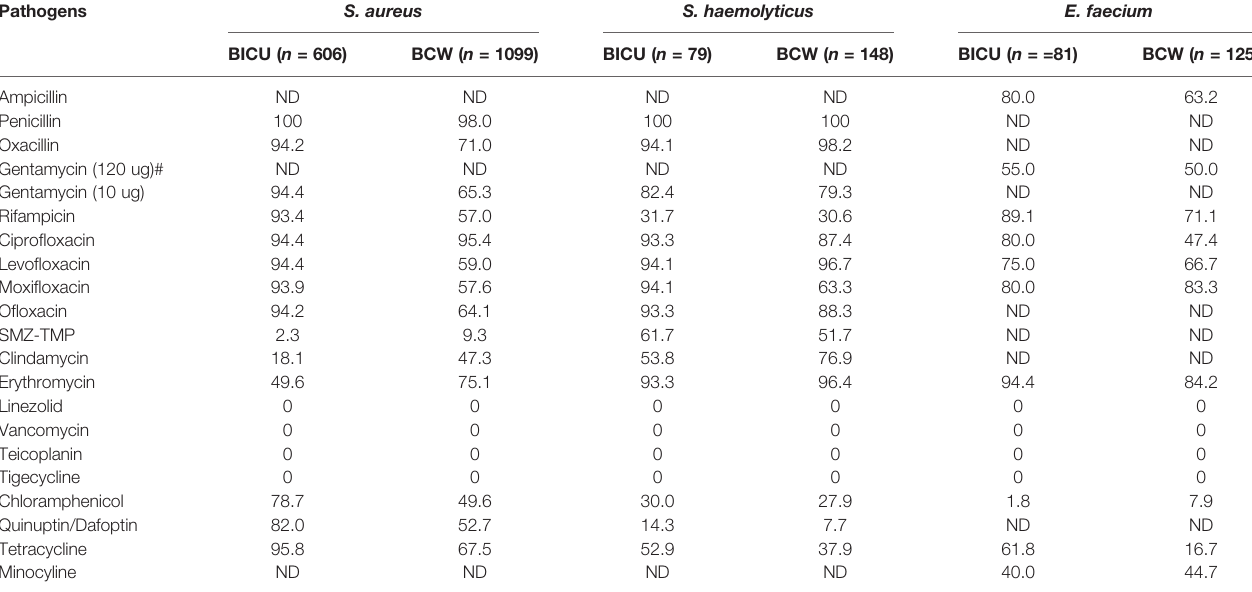
TABLE 4 | Antimicrobial resistance of Gram-positive bacteria in BICU and BCW.